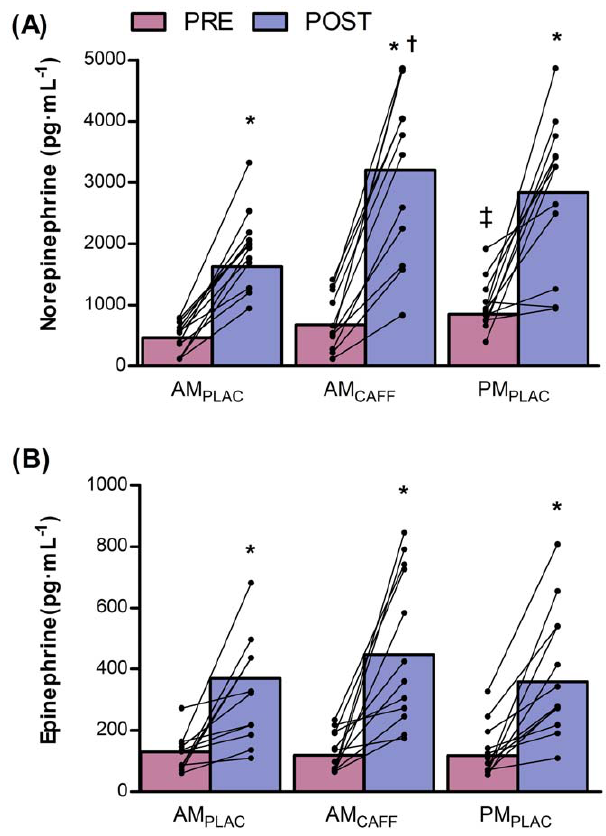
Figure 3. Catecholamine response to a maximal sympathetic stimulation bout of exercise. Norepinephrine and Epinephrine changes following a bout of 6 free-weight squats repetitions with a load of 85% of 1 RM in the morning (10:00 am) without (AM PLAC ) or with caffeine ingestion (i.e., 3 mg kg 2 1 ; AM CAFF ) and in the afternoon (18:00 pm; PM